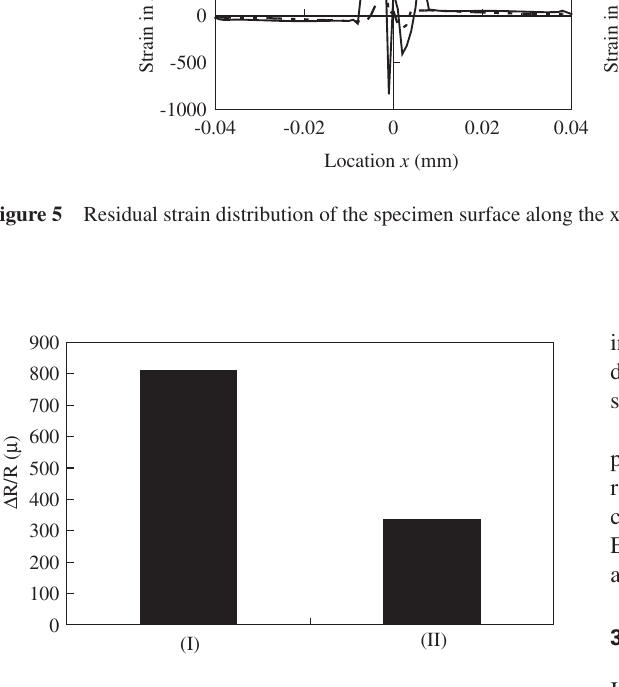
Figure 6 Electrical resistance change due to the insulation of the current path obtained by FEM analyses.